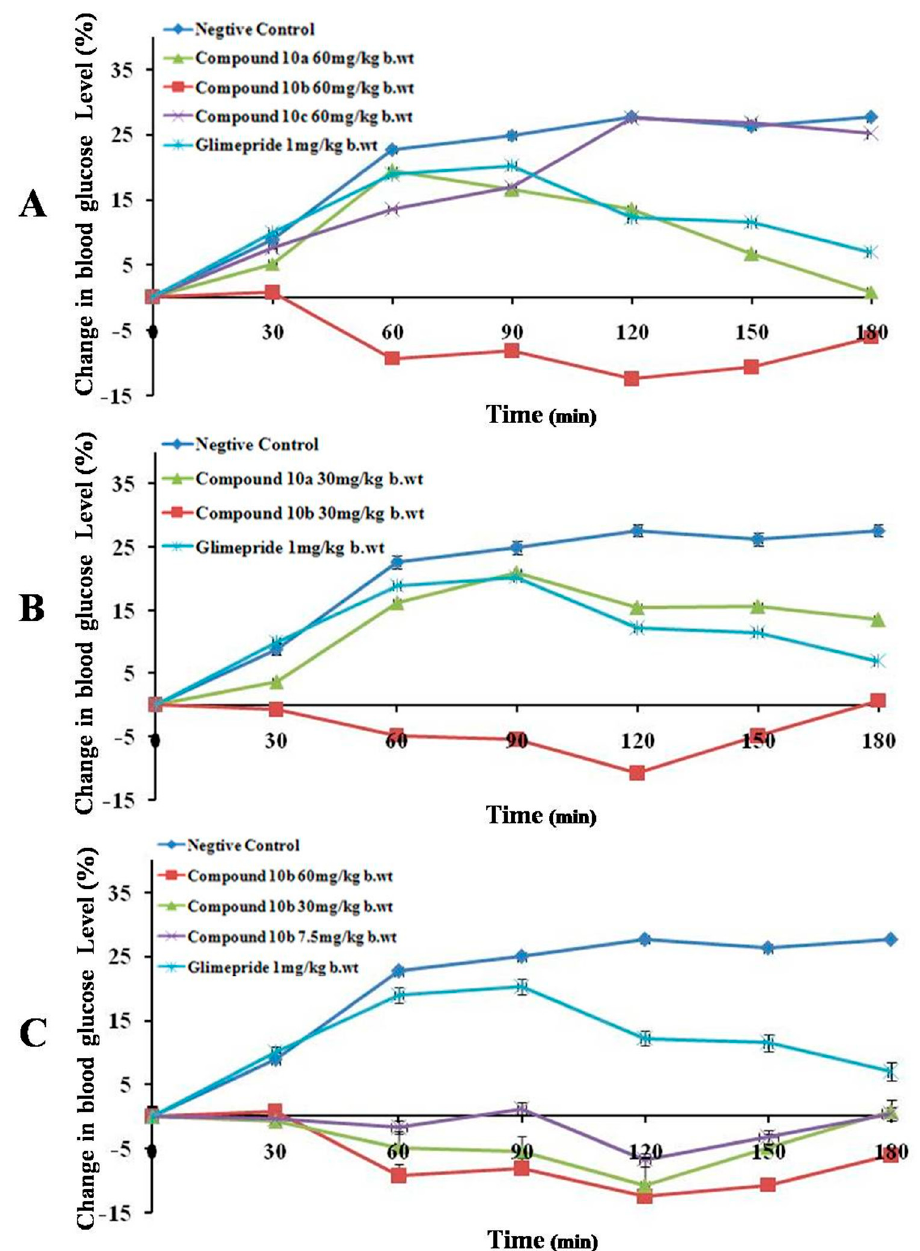
Figure 3. Change of blood sugar level in fasting STZ diabetic mice. ( A ) 10a – c (60 mg/kg b.wt); ( B ) 10a and 10b (30 mg/kg b.wt); ( C ) 10b (60 mg/kg, 30 mg/kg and 7.5 mg/kg b.wt). Each bar results are the mean ± SEM for n = 5–8 rats per treatment group.2.2.1. Normal Mice (Group A).